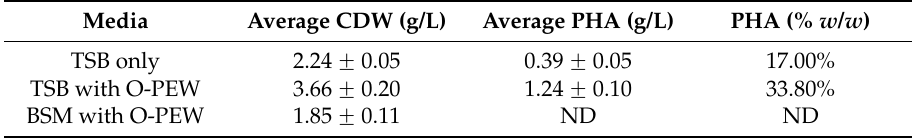
Table 1. PHA production by Ralstonia eutropha using 5 g/L PE wax, during 48 h of incubation in TSB, TSB with O-PEW and BSM with O-PEW at 30 °C. Presented values are the means of triplicates. Media